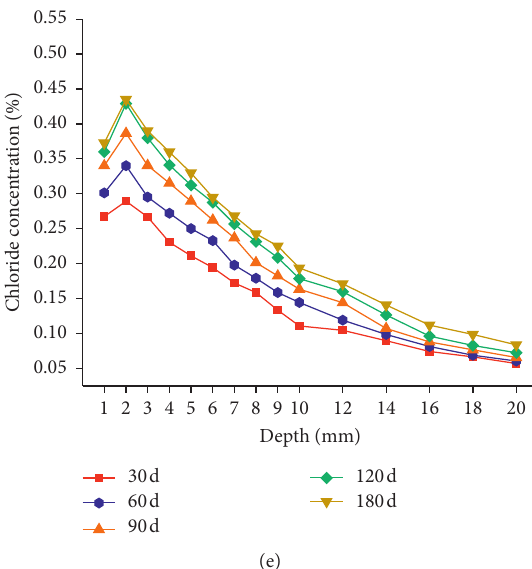
Figure 7: Chloride concentration distribution of C40 concrete different fiber type and content. (a) HC-40. (b) BC-40-0.1. (c) PC-40-0.1. (d) BPC-40-0.1. (e) BPC-40-0.2.